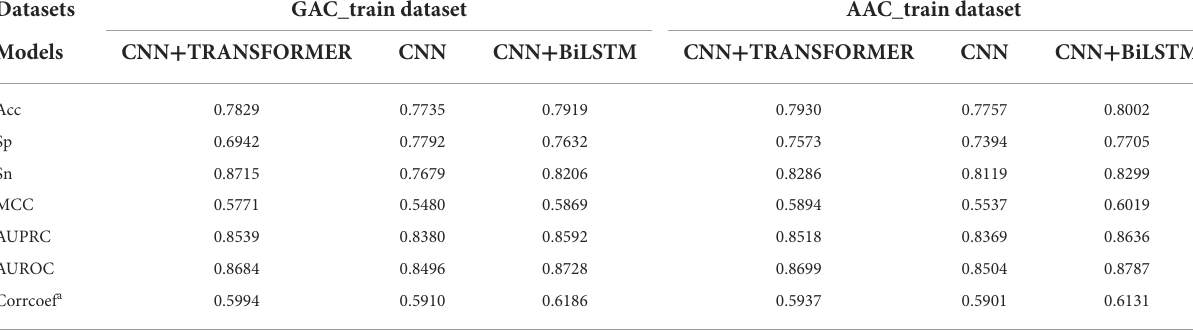
TABLE 2 Performance of three multi-task deep learning models on the two training datasets.